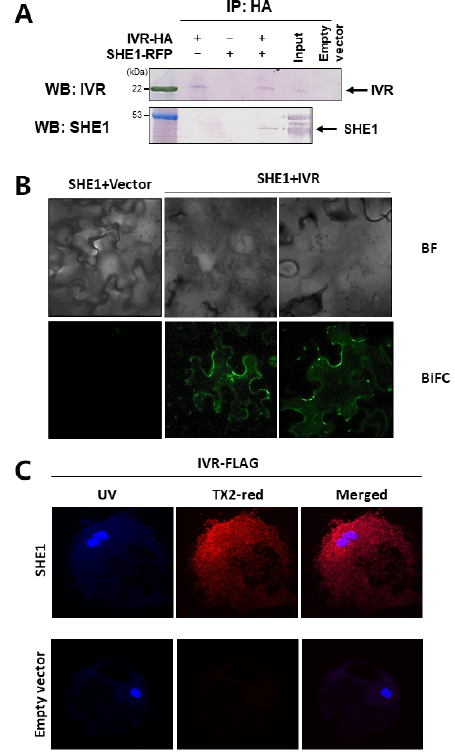
Figure 7. Interactions between IVR and SHE1. ( A ) Co-IP assay showing interaction of IVR and SHE1 in vivo. N. benthamiana plants were infiltrated with Agrobacterium harboring plasmids expressing IVR tagged with HA (IVR-HA), SHE1 fused to the red fluorescent protein (SHE1-RFP), both plasmids, or an empty vector control. At 3 days after infiltration, the agroinfiltrated leaves were extracted and subjected to immunoprecipitation (IP) performed with antiserum to the HA-tag on IVR. The immunoprecipitated material was denatured and fractionated by SDS-PAGE and electroblotted to nitrocellulose membranes. Western blot detection was performed using antisera to IVR or SHE1. M = Protein molecular weight markers. ( B ) Co-localization of SHE1 and IVR in N. benthamiana as determined by bimolecular fluorescence complementation (BiFC) of SHE1 and IVR fused to halves of enhanced YFP (eYFP) expressed in agroinfiltrated N. benthamiana leaves and examined by confocal microscopy. The agroinfiltrated plasmids control shown contained SHE1 fused to the N-terminal half of eYFP and the empty vector for expressing the C-terminal half of eYFP. Upper panels show the bright field (BF) view, whereas lower panels show the BiFC, viewed under UV light. ( C ) Co-localization of SHE1 and IVR in N. benthamiana as determined by Duolink in situ proximity ligation assay in transfected protoplasts co-expressing IVR-FLAG and SHE1-HA, detected by mouse anti-FLAG mAb and rabbit anti-HA mAb, respectively, with co-localization detected by Texas red dye (TX2-red) using confocal microscopy (upper panels). The nucleus was detected by DAPI staining (blue). The control transfection, expressing IVR-FLAG plus an empty HA-vector, is shown in the lower panels. Note: the presence of fixed cytoplasmic constituents above the nucleus, containing proteins interacting with each other and detected by TX2-red in the Duolink detection system, means that the red dye above the nucleus does not allow one to distinguish interactions that occur in the cytoplasm alone from those occurring in both the cytoplasm and the